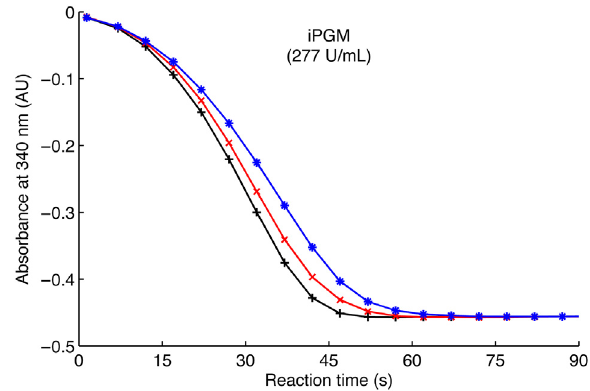
Figure 7. Enzymatic activity assay of phosphoglycerate mutase (iPGM). The activity was calculated using the maximum linear rate observed in each trace (Equation 1) and reported as the average of triplicate measurements. A typical activity is shown.